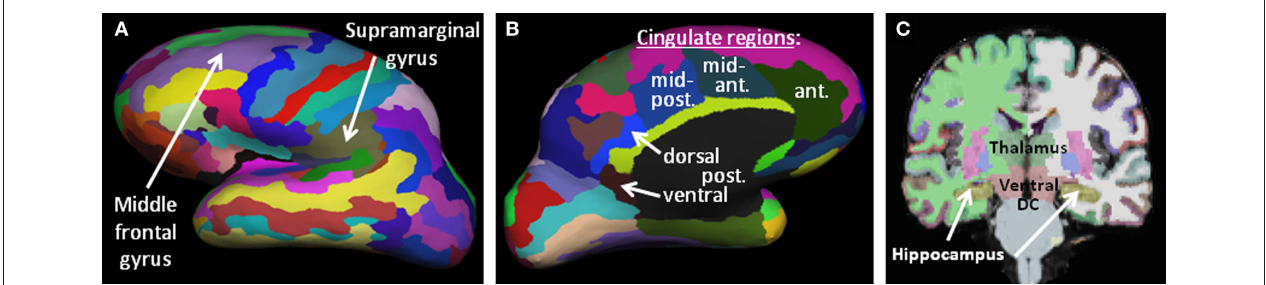
FIgure 1 | Brain morphometric parcellation results for an example subject, identifying key regions from this study. (A,B) Lateral and medial representations of the inflated cortical surface showing the 75 parcellated cortical regions per hemisphere. Only the left hemisphere is shown, laterally (A) and medially (B) . (C) Coronal slice highlighting several subcortical structures automatically identified by the Freesurfer algorithms (thalamus, ventral diencephalon, hippocampus, basal ganglia,